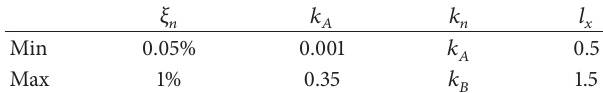
Table 1: Bounds for theMonteCarlo simulations for 𝑙 ̸= 1 and V = 1